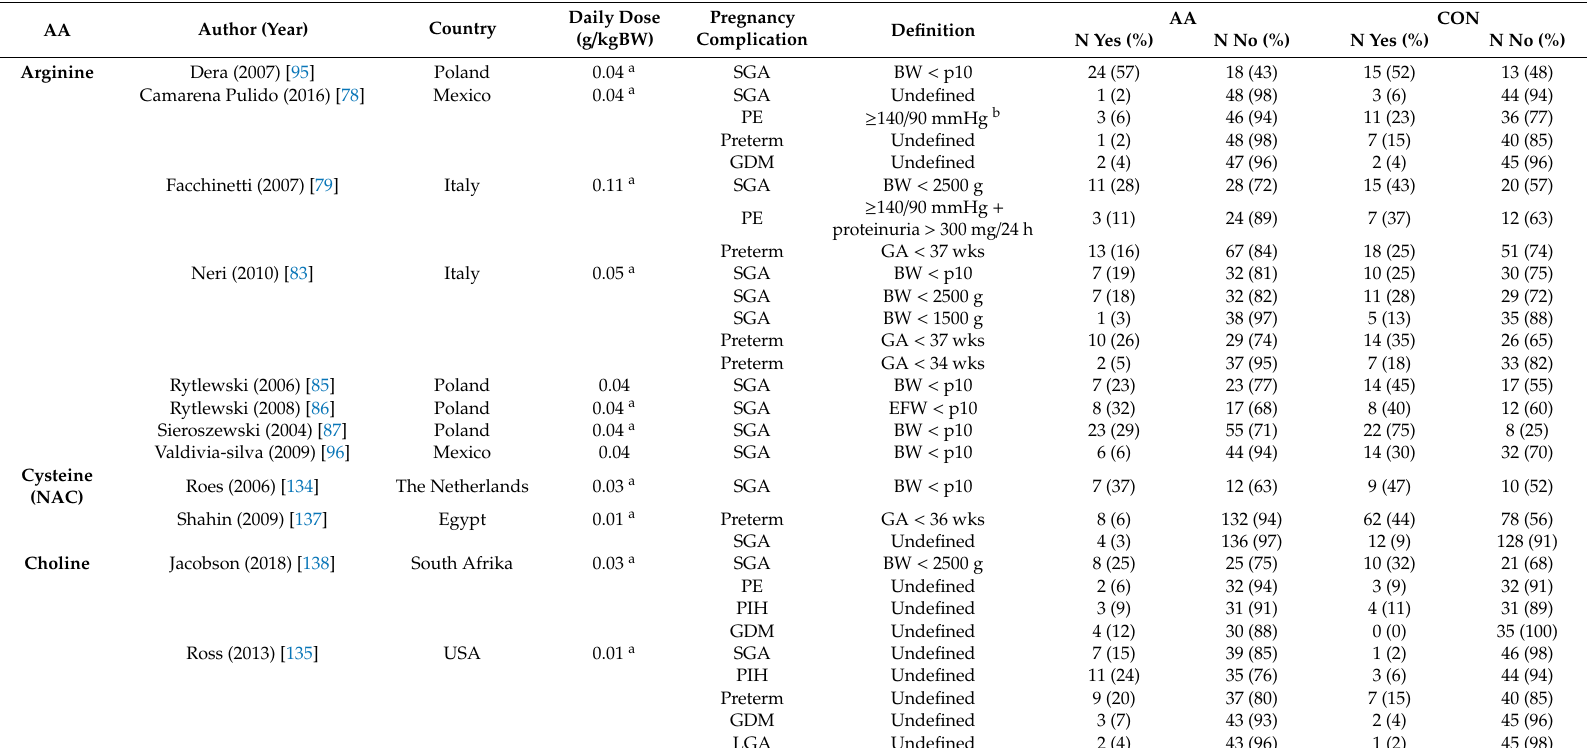
Table A7. Data extraction on development of pregnancy complication in risk population in human